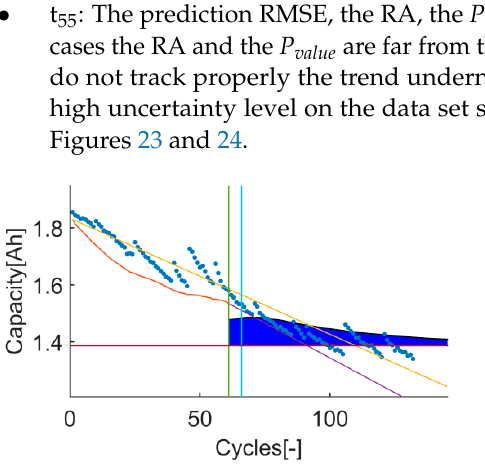
Figure 23. Time-instant figure of test 2 on t 55 .